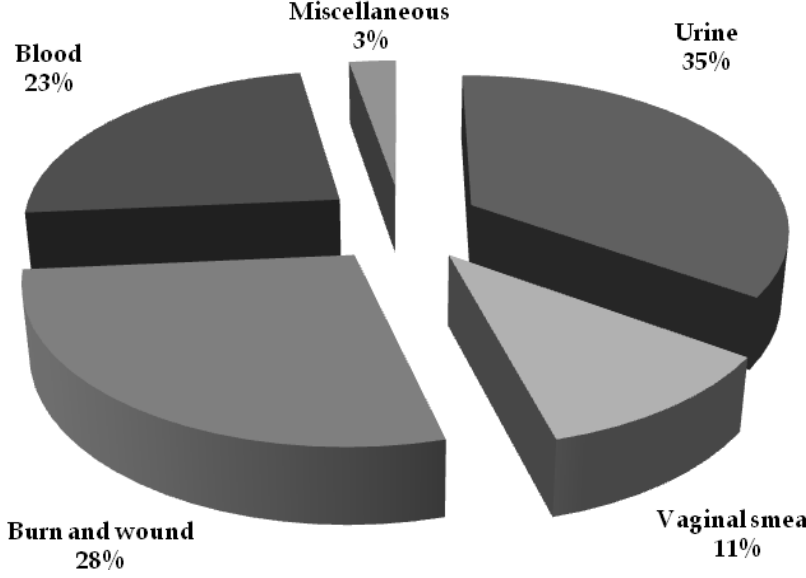
FIGURE 1. Distribution of isolated Klebsiella spp. among different specimens.